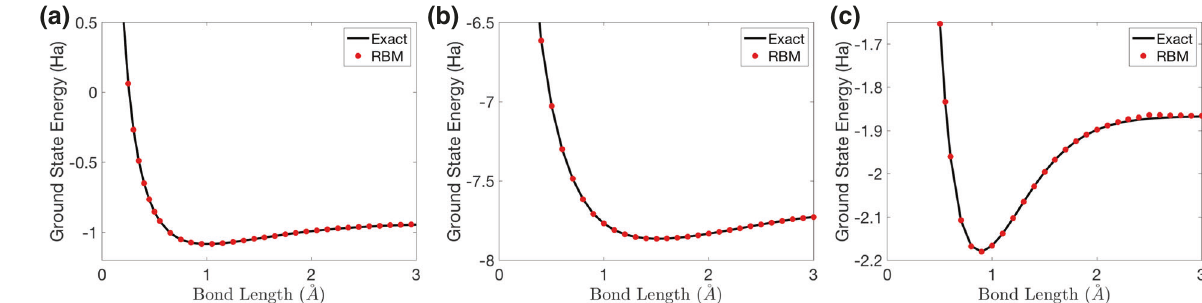
Fig. 2 Numerical results for molecular systems. The ground state energy of H 2 , LiH, and linear H 4 molecules as a function of inter-nuclear distances. The energies computed with the NQS-ITE algorithm and the exact diagonalization are solid red dots and solid black lines, respectively. Results for a H 2 ( N = 2, M = 2), b LiH ( N = 4, M = 4), and c linear H 4 ( N = 8, M =